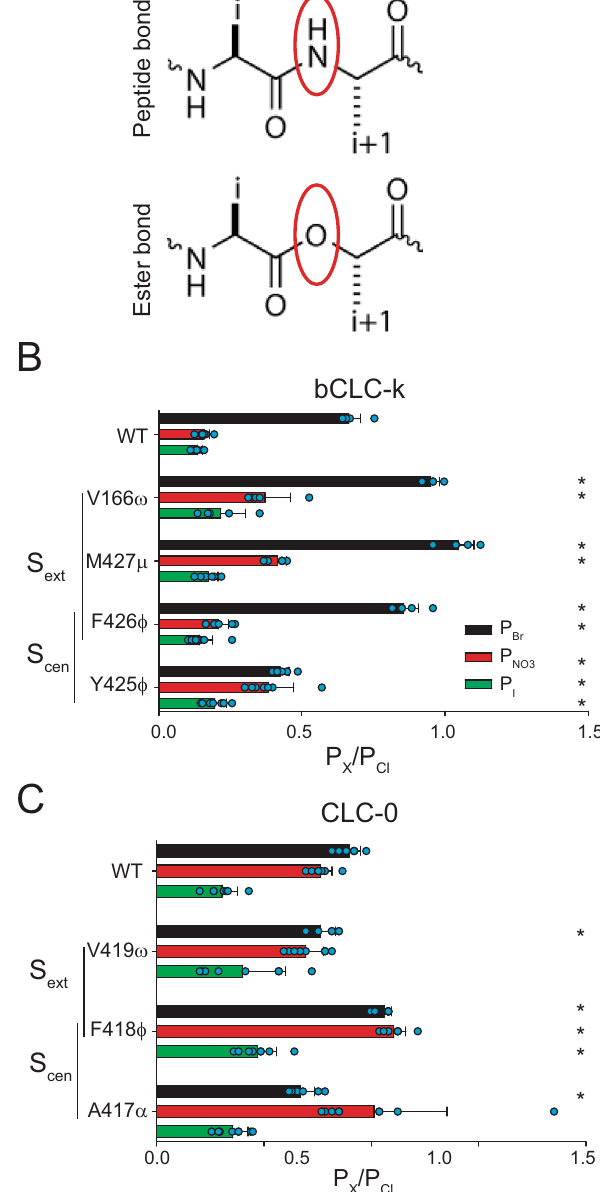
Fig. 2 | Role of backbone amides in anion selectivity of CLC-0 and bCLC-k. A Schematicrepresentationofpeptide(toppanel)andesterbonds(bottompanel). ( B , C ) Effect of replacing backbone amides with ester oxygens at positions lining S ext and S cen in bCLC-k ( B ) and CLC-0 ( C ) on P Br (blackbars), P NO3 (red bars) and P I (green bars). Nomenclature of α -hydroxy acid substitutions is explained in Meth- ods. Data are Mean ± St.Dev. of n >4 repeats from N ≥ 3 independent oocyte bat- ches,individualdatapointsareshownascyancircles.Thestatisticalsigni fi canceof theeffectsofthemutantsonthepermeabilityratiosofeachion(indicatedby*)was evaluated with a one-sided Student ’ s t -test with a Bonferroni correction (see “ Methods ” ). Mean values and p values are reported in Supplementary Table